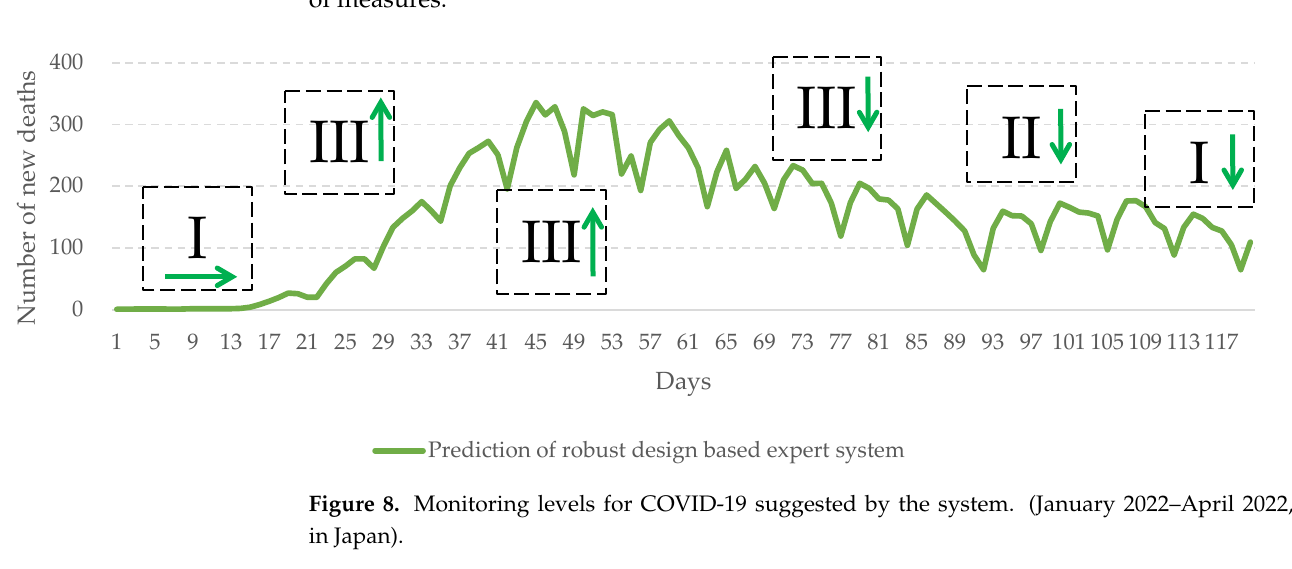
Figure 8. Monitoring levels for COVID-19 suggested by the system. (January 2022–April 2022, in Japan).